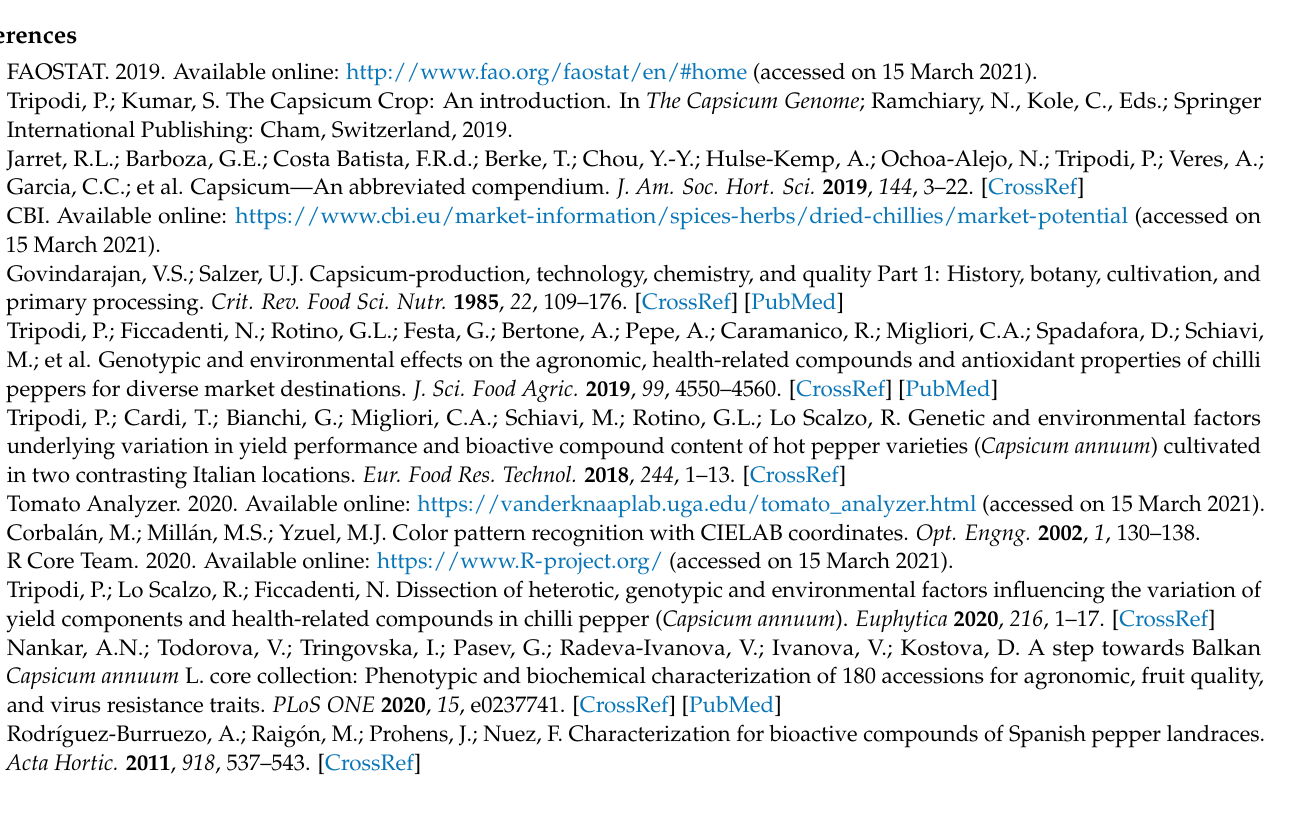
Table S3: Variable contribution in % for the traits in the first two